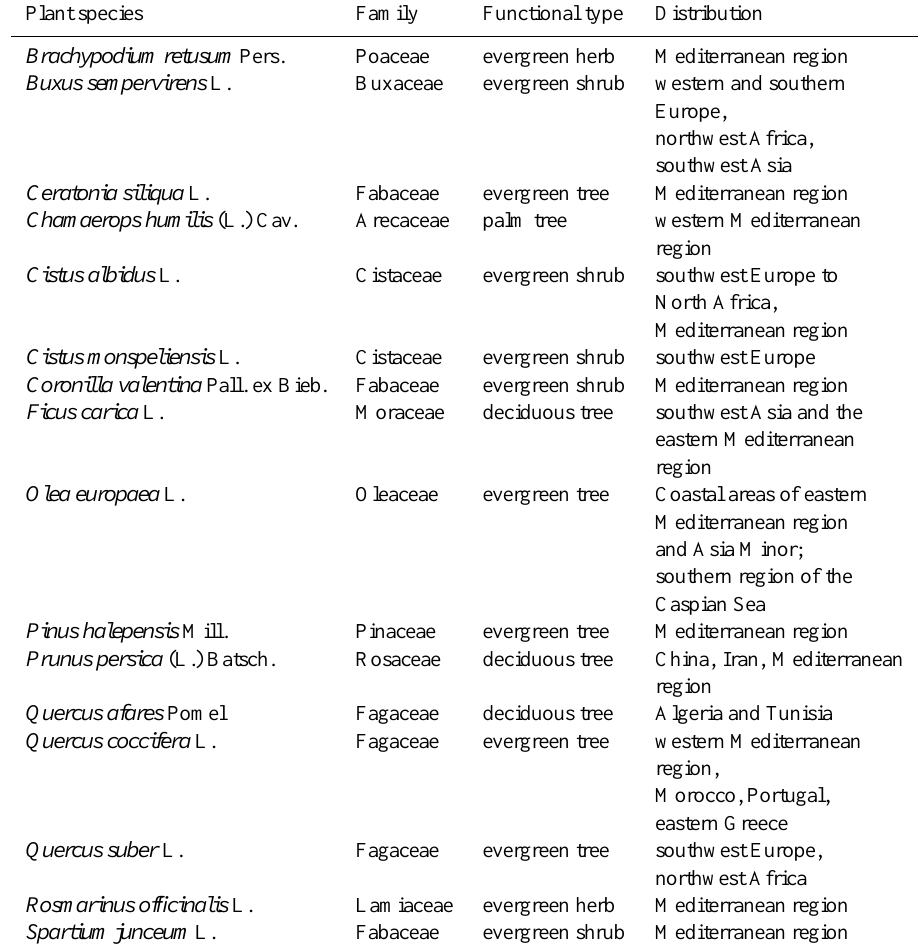
Table 2. Plant species, family, functional type and occurrence of the 16 investigated Mediterranean plant species. Plant